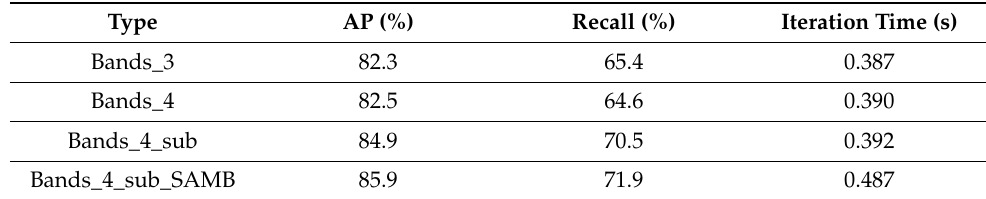
Table 3. Test results for different models.